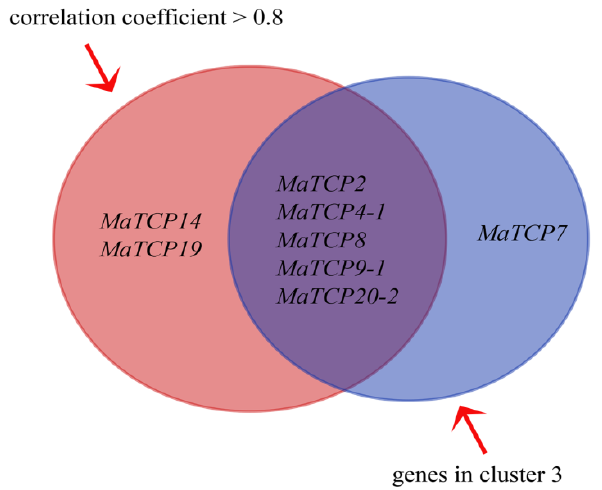
Figure 3. Expressions of MaTCP genes in GY12 seedlings during root development. ( A ) Images of 21-, 28-, 35-, and 42-day-old GY12 seedlings. Scale bars, 10 cm. ( B ) Corresponding root lengths. Each black triangle represents a GY12 seedling. ( C ) RT-qPCR-based time series analysis of the expressions of 15 MaTCP genes in GY12 seedlings at five developmental time points. Roots were collected from 10 individuals at each time point (21, 28, 35, 42, and 49 days after germination), and their lengths were measured. ( D ) Clustering of MaTCP genes based on the results of the time series analysis.